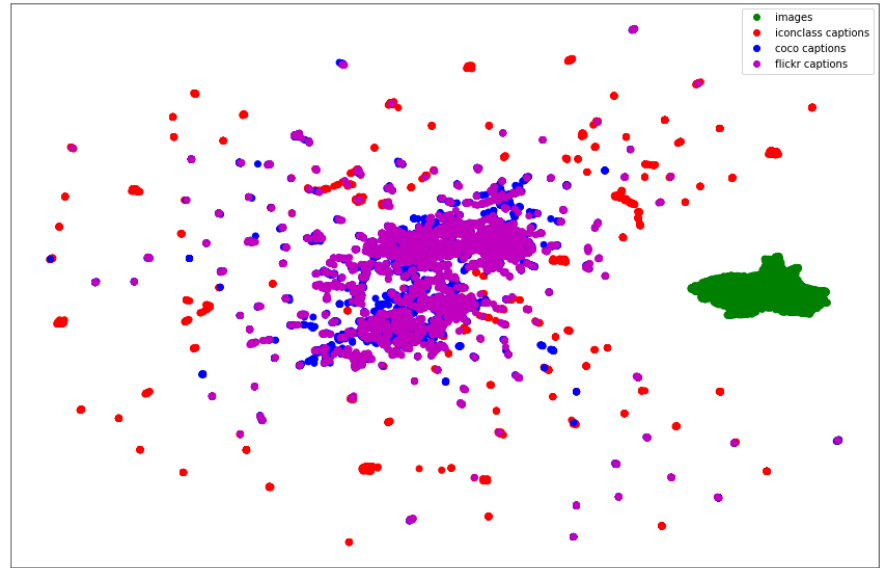
Figure 7. UMAP (Uniform Manifold Approximation and Projection) plot depicting the CLIP (Contrastive Language-Image Pre-Training) model embeddings of the images and various generated captions on a subset of the WikiArt